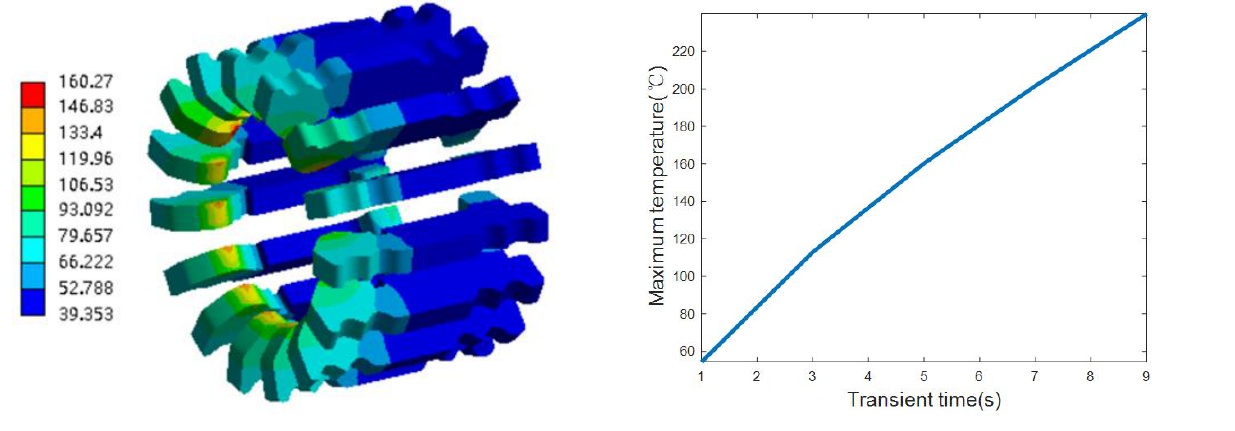
Fig. 9. Temperature distribution of plum blossom contact at short-circuit current of 40kA/5s